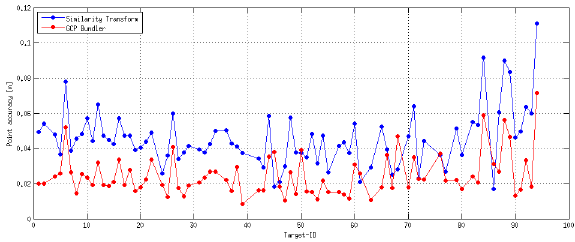
Figure 9: Using all 850 images and all available GCPs in the constrained bundle adjustment, a mean measurement uncertainty dropping from 4.54cm to below 2.45cm is reached.